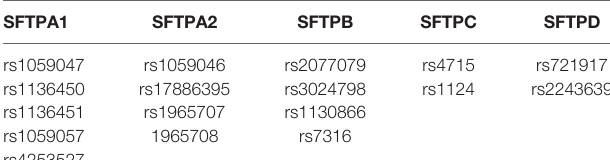
TABLE 2 | SNPs of each surfactant protein gene analyzed in this